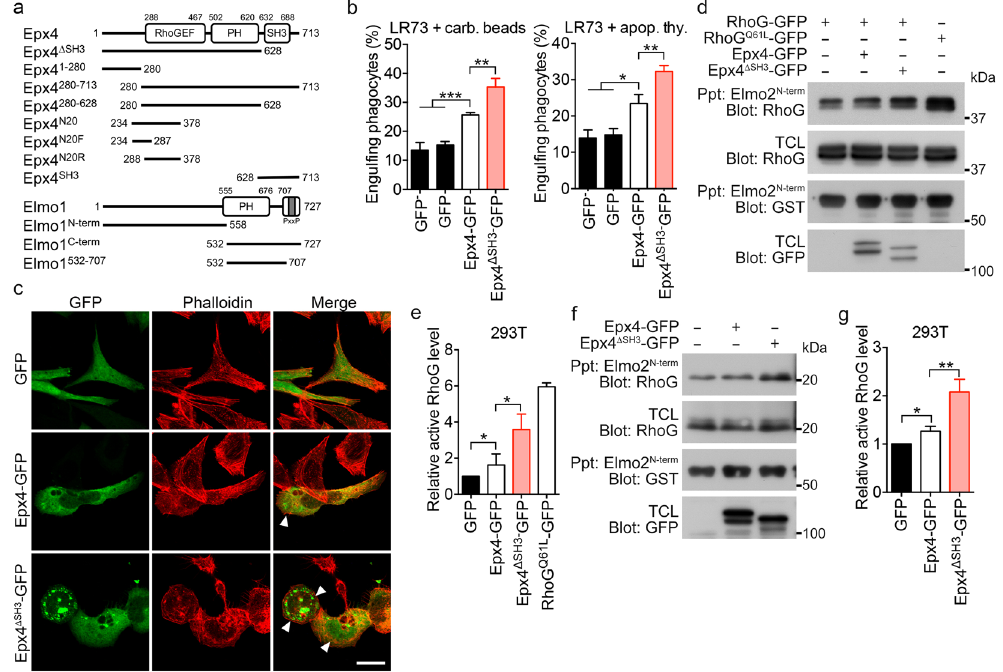
Figure 1. The activity of Ephexin4 is negatively regulated by its SH3 domain. ( a ) Schematic diagram of Ephexin4 and Elmo1, and their truncation mutants used in the study. Epx4, Ephexin4; GEF, Guanine nucleotide exchange factor; PH, Pleckstrin homology domain; SH3, SRC homology 3 domain. ( b ) LR73 cells were transfected with the indicated plasmids, incubated with 2 µ m carboxylated beads (left) or apoptotic thymocytes (right) for 2 h, and analyzed by flow cytometry. GFP- and red fluorescence–positive phagocytes were considered to represent phagocytes that had engulfed targets. GFP − indicates the non-transfected population of the cells. ( c ) LR73 cells were transfected with the indicated plasmids and stained with phalloidin. Images were obtained using confocal microscopy. Arrow heads indicate membrane ruffles. Scale bar, 20 µ m. ( d , e ) 293 T cells were transfected with the indicated plasmids and lysed. The resultant lysates were incubated with GST-Elmo2 N-term - bound GST beads for 1 h. Exogenous active RhoG levels were detected with immunoblotting ( d ) and quantified from four independent experiments ( e ). ( f , g ) 293 T cells were transfected with either Ephexin4 or Ephexin4 Δ SH3 . Endogenous active RhoG was co-precipitated with GST-Elmo2 N-term and detected by immunoblotting ( f ). Three independent experiments were performed, and the levels of active RhoG were quantitated ( g ). Data are shown as the mean ± standard deviation and are representative of at least three independent experiments. * P < 0.05, ** P < 0.01. Immunoblots are cropped for conciseness and their full-length blots are shown in Supplementary S3. Epx4, Ephexin4; TCL, total cell